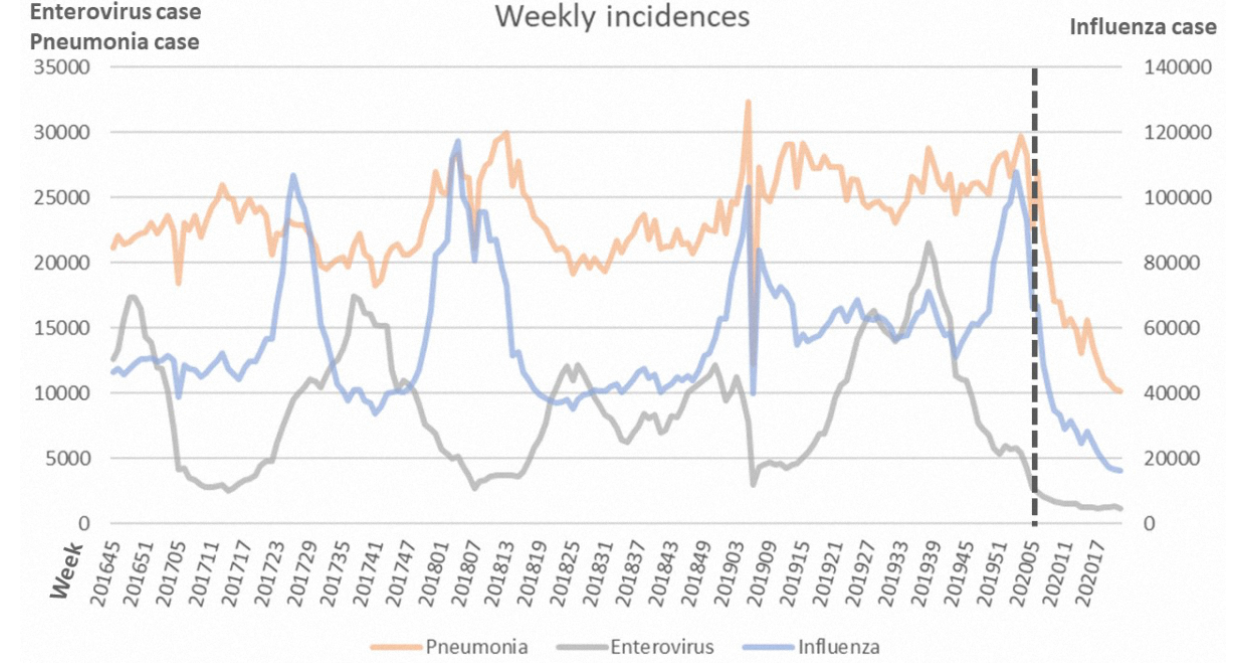
Figure 1. Weekly incidences of influenza, enterovirus, and pneumonia in 2017-2020. Dotted line indicates a significant decrease in all three diseases after week 6 of